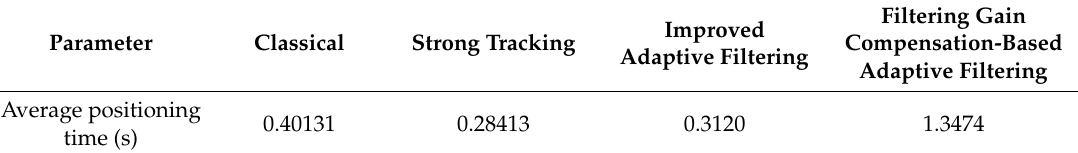
Table 2. Comparison of the positioning simulation time of the filtering